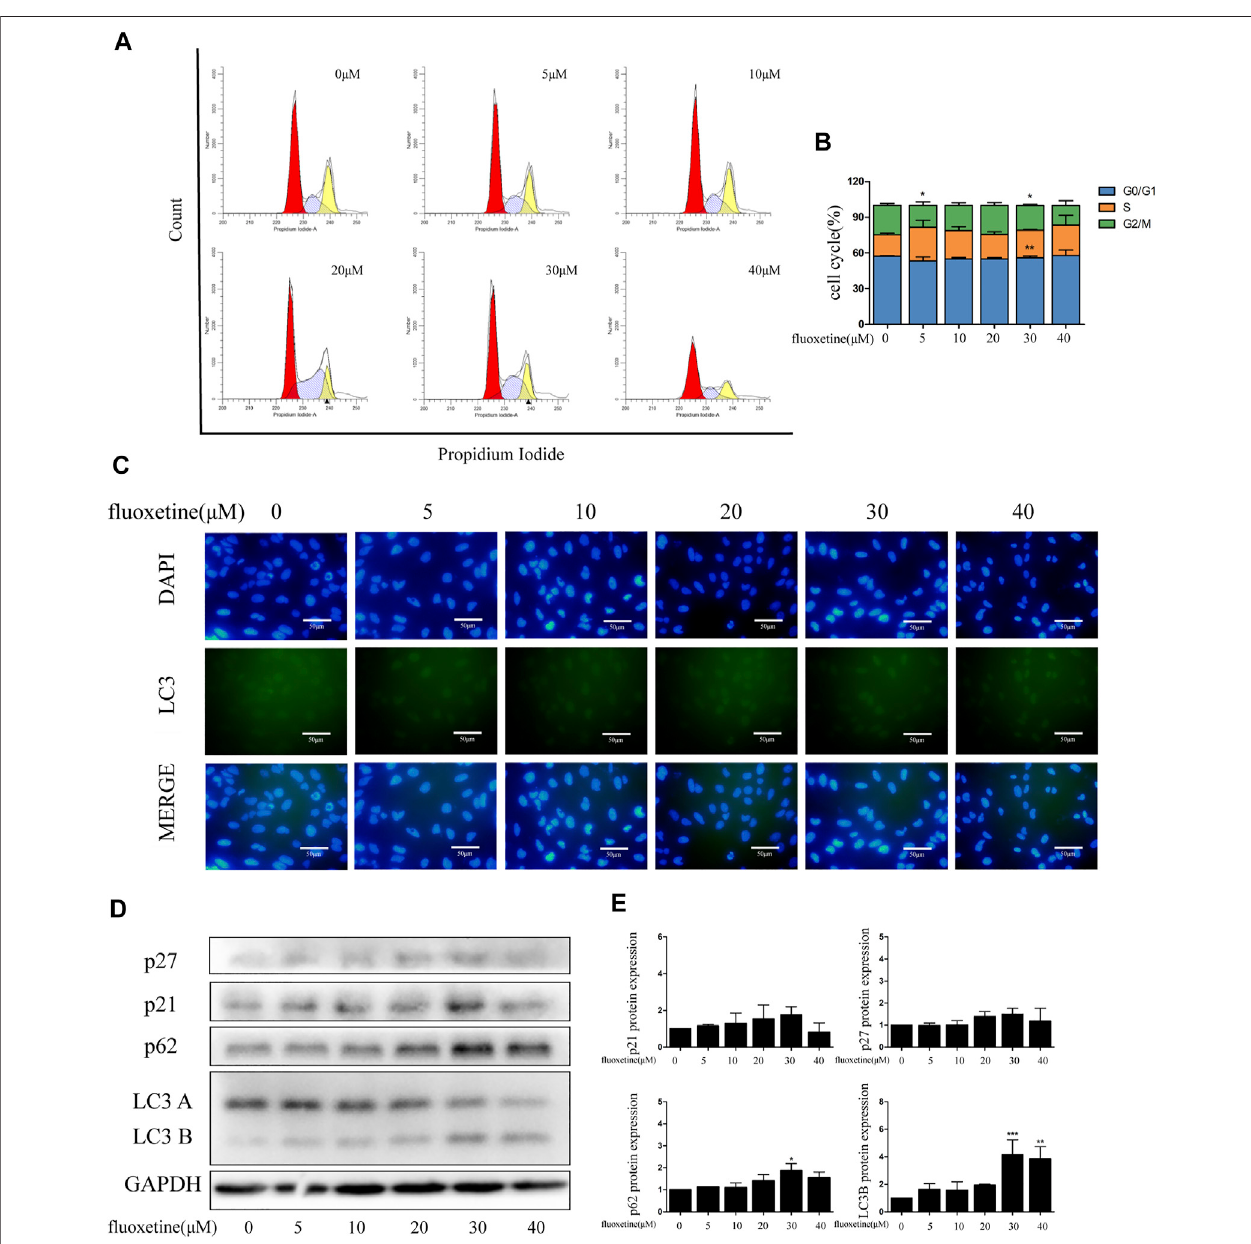
FIGURE 8 | Fluoxetine exerted anti-tumor effects while not damaging normal cells. (A – B) Distribution of the cell cycle in normal lung epithelial cells treated with fl uoxetine (0 – 40 μ M) was analyzed by fl ow cytometry. (C) Immuno fl uorescence of LC3 (green) and DAPI (blue) was used to observe the autophagy. Scale bars were 50 μ m. (D – E) Expression ofp27, p21, p62, and LC3 was tested byWesternblot. The images were collected from differentparts ofthe same gel.Dataare presented as mean ± SD; * p < 0.05, ** p < 0.01, *** p <